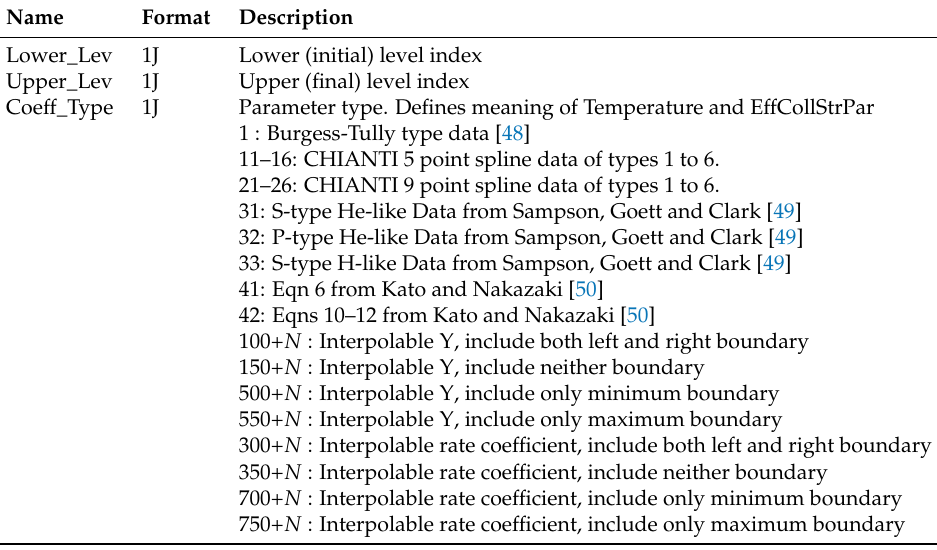
Table A4. APED EC (electron collision) file